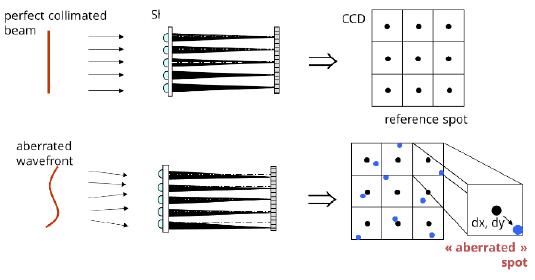
Fig. 1. Principle of Shack-Hartmann wavefront sensing, showing a perfect (top) and aberrated (bottom) wavefront.